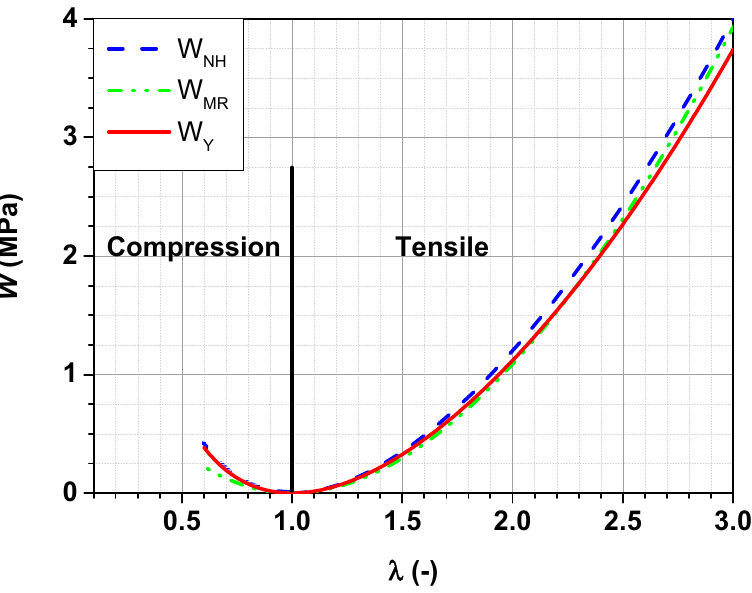
Figure 5. Strain energy density function W as a function of the stretch ratio λ for SBR filled with 70 phr carbon black N234.